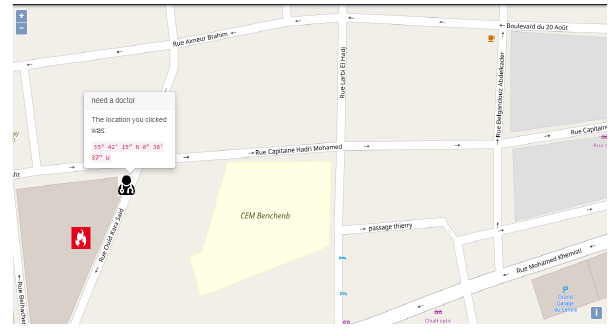
Figure 8 . Figure how the platform